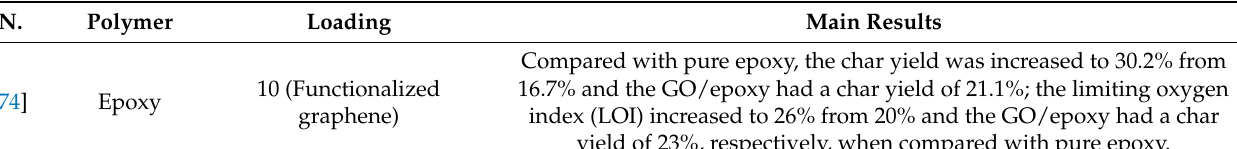
Table 2. Summary of flammability of polymer nanocomposites based on functionalized graphene oxide.